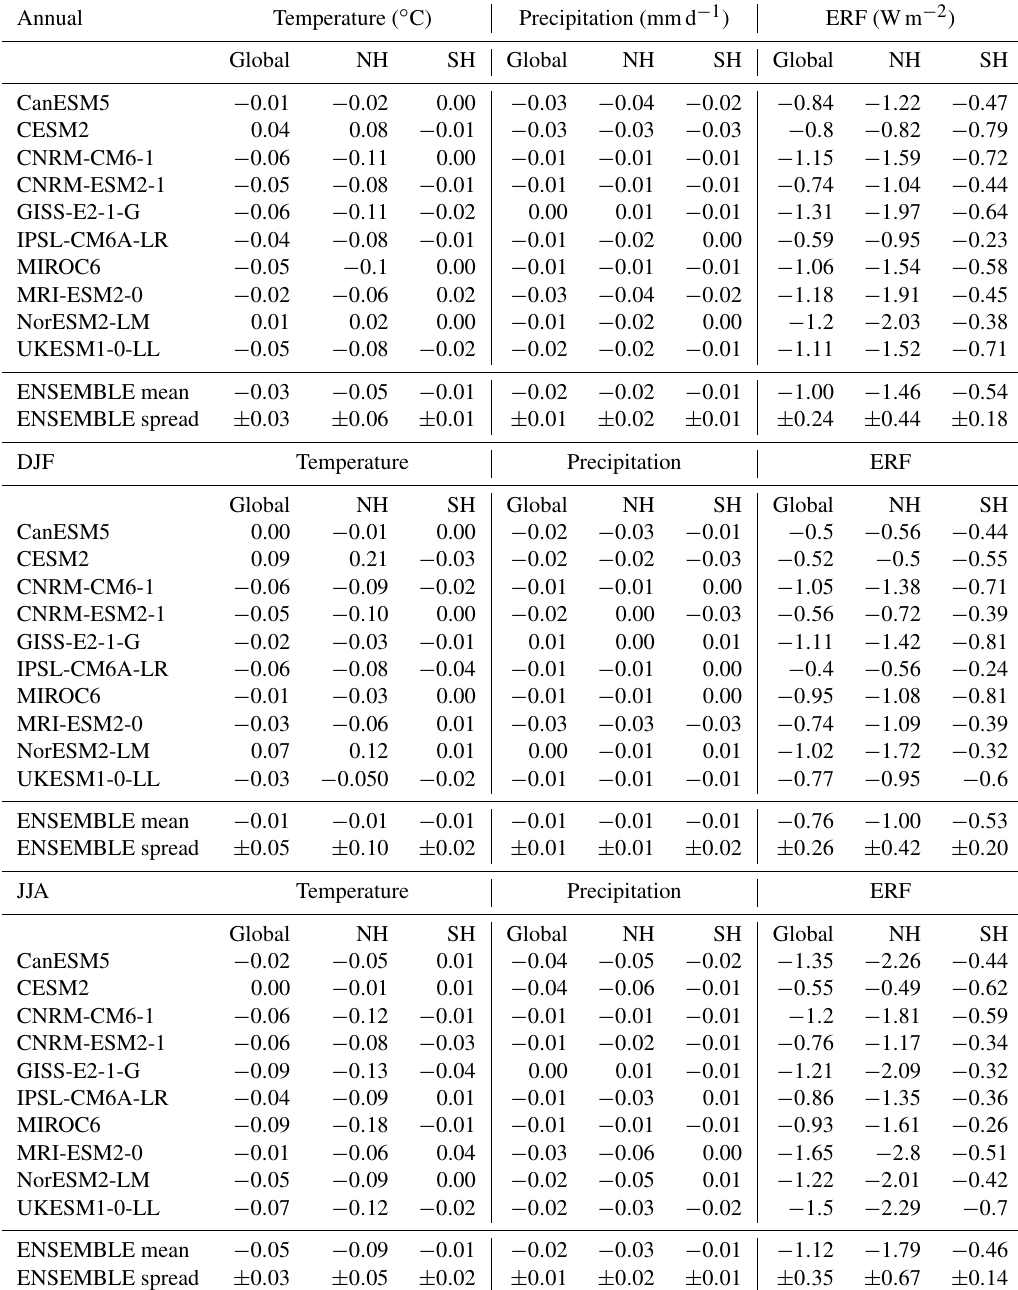
Table 2. Differences between piClim-aer and piClim-control in temperature, precipitation and ERF for each model on an annual basis, as well as for DJF and JJA. The values are given as mean values for global, Northern Hemisphere (NH) and Southern Hemisphere